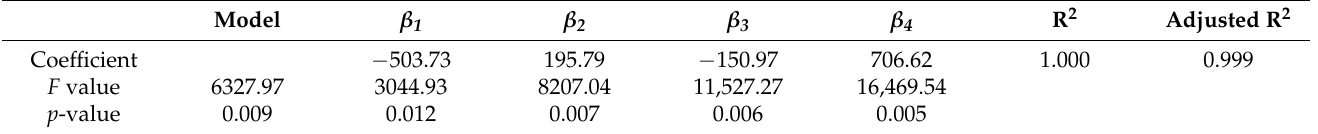
Table 5. ANOVA statistical analysis for the response surface linear model of the share of questionees not willing to pay any extra cost for bioplastic implementation in the function of the self-declared economic status of questionees.